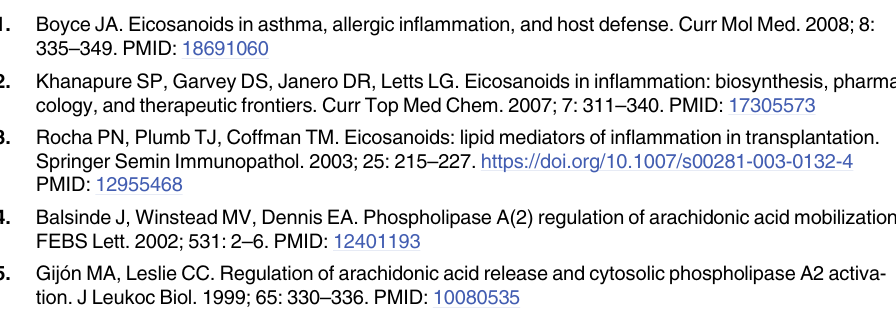
S17 Fig. Sequence and structural details of the modeled fly LTC4S candidate. A. Domain architecture of LTCS4 and CG33178 and known/predicted functional residues B. Pairwise alignment of CG33178 and 2PNO generated from structural superposition showing shared secondary structure elements and known/predicted functional residues (marked with red asterisks; the green asterisk denotes the analog for R31) C. Pairwise alignment of CG33178 and 2PNO generated from structural superposition with conserved residues highlighted using the physiochemical color scheme (CLUSTALX) D. Validation of the CG33178 model: ProQ2 qual- ity score mapped to a 3D model of CG33178 (left); ProSA global quality score ranking (mid- dle) and per-residue quality graph (right) E. LTCS4 (2PNO, cyan-blue) superimposed on the predicted structure of CG33178 (green-red) with potential matches for conserved functional residues highlighted F. Summary of features shared by LTCS4 and potential D . melanogaster ortholog CG33178. S18 Fig. Sequence and structural details of the modeled fly ALOX5AP candidate. A. Domain architecture of ALOX5AP and CG33177 and known/predicted functional residues B. Pairwise alignment of CG33177 and 2Q7M generated from structural superposition showing shared secondary structure elements C. Pairwise alignment of CG33177 and 2Q7M generated from structural superposition with conserved residues highlighted using the physiochemical color scheme (CLUSTALX) D. Validation of the CG33177 model: ProQ2 quality score mapped to a 3D model of CG33177 (left); ProSA global quality score ranking (middle) and per-residue quality graph (right) E. ALOX5AP (2Q7M, cyan-blue) superimposed on the predicted struc- ture of CG33177 (green-red) F. Summary of features shared by ALOX5AP and potential D . melanogaster ortholog